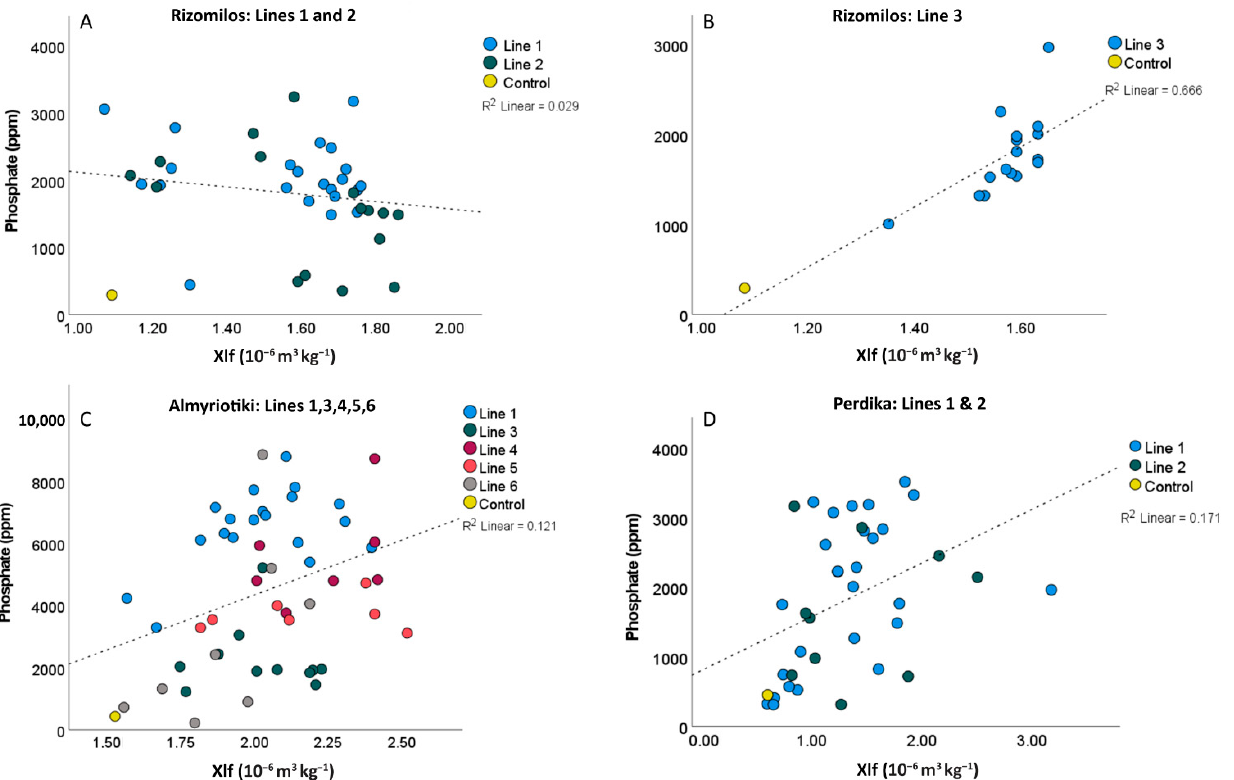
Figure 5. Bivariate plot of phosphate concentration and χ lf showing correlation between parameters at the three sites.